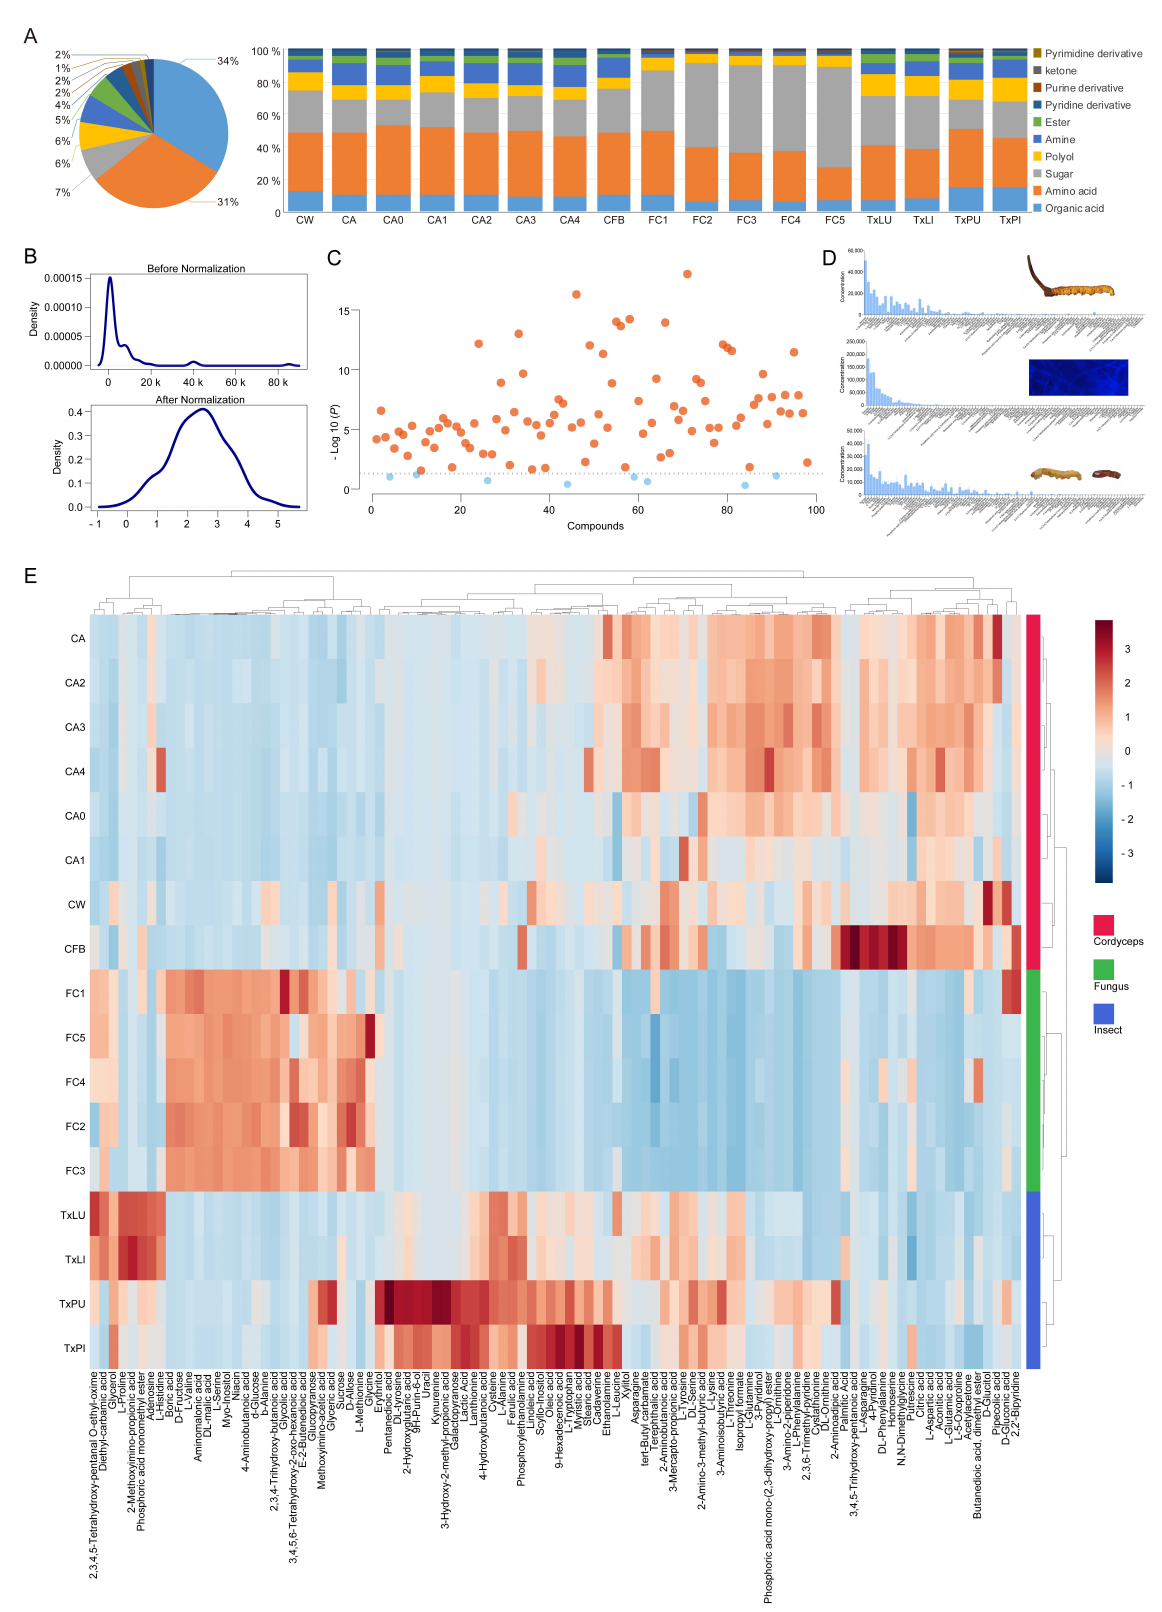
Figure 2. Evaluation of metabolite profiles from the tested treatments. ( A ) The pie chart showed overall proportions of the metabolite classes identified in all products. The bar chart showed the proportions of the same metabolite classes in each treatment from either Chinese cordyceps, O. sinensis alone or Thitarodes alone. ( B ) Kernel density plots before and after